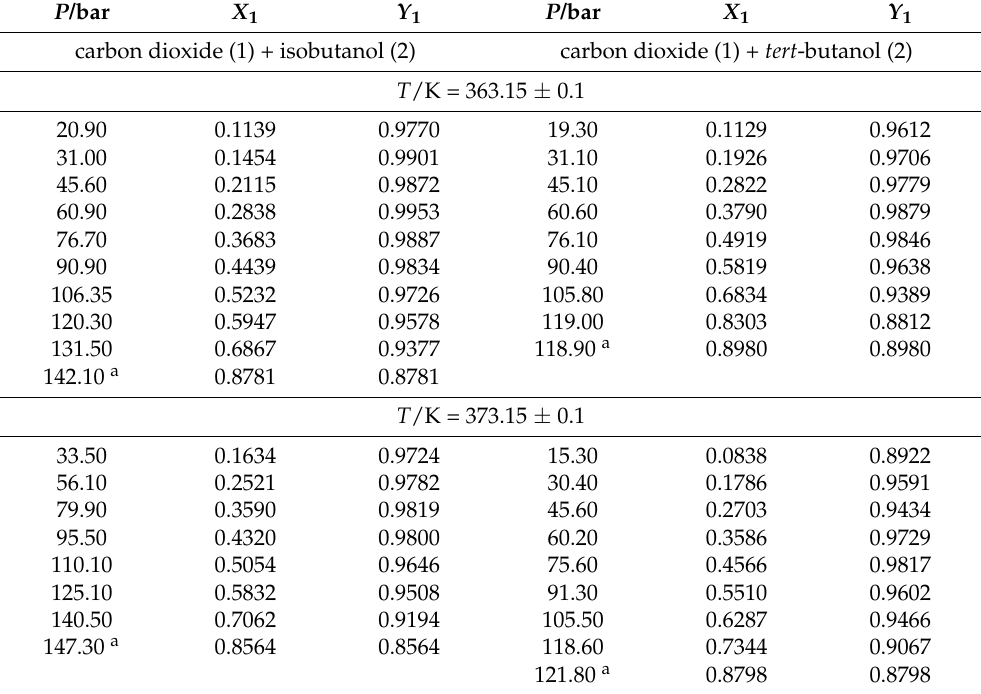
Standard uncertainties: u ( T ) = 0.1 K, u ( P ) = 0.1 bar, u ( X 1 ) = 0.001, u ( Y 1 ) = 0.005. a Critical